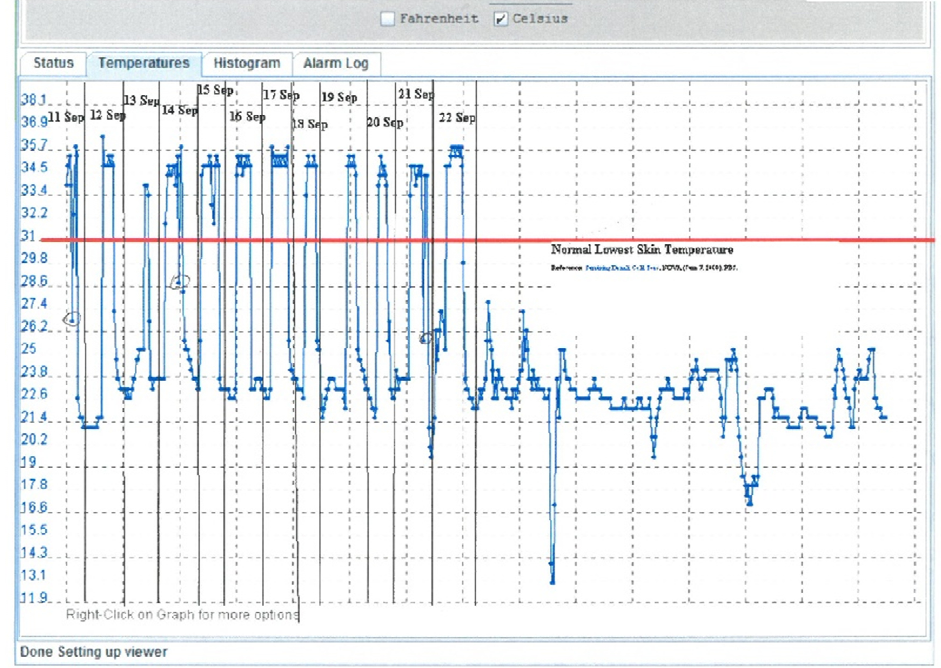
Figure 6. An example of a period with daytime and nighttime use of the brace. The heat sensor would register the temperature rise when the brace was worn. A period of brace use is seen on the left-hand side of the figure (compliance) and a period of non-compliance is seen on the right-hand side of the figure. (Upper-A). Table 4. Brace events and brace history. * 1 Patient ID. * 2 Brace events and clinical comments. * 3 Types